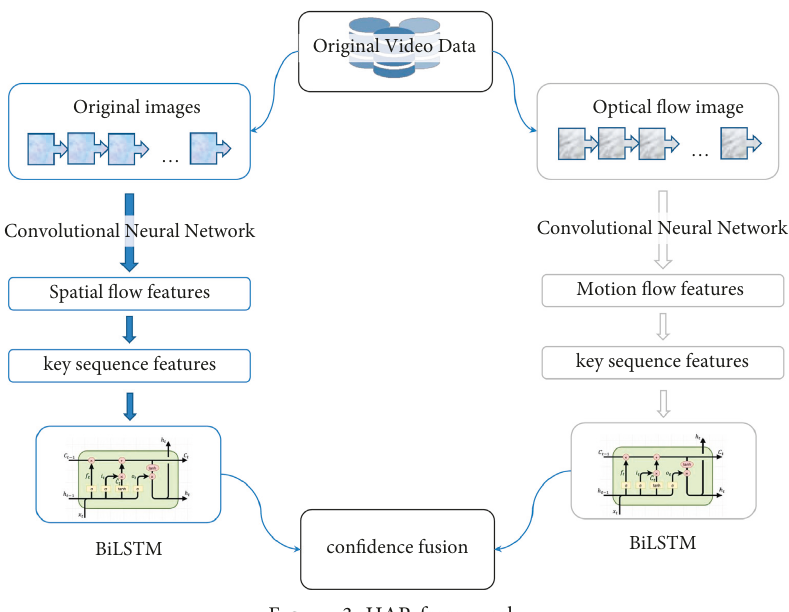
Figure 3: HAR framework.